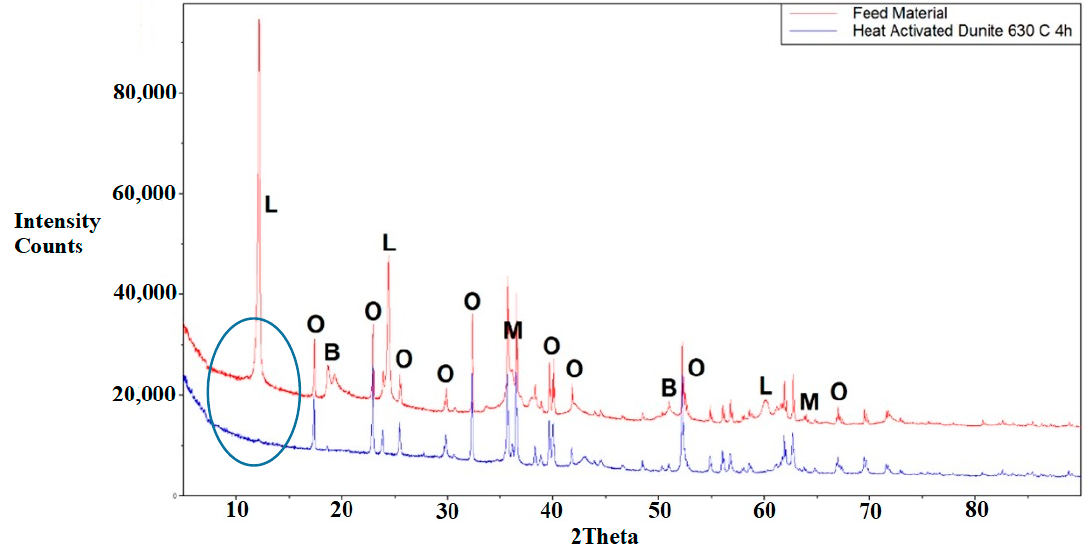
Figure 5. Raw dunite (top) and heat-treated dunite (bottom). L = Lizardite, B = Brucite, O = Olivine, M = Magnetite.